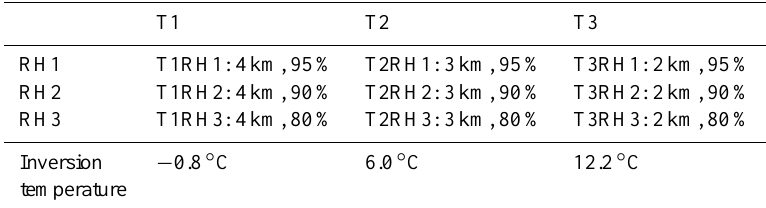
Table 1. A summary of the notations, inversion base height and RH levels in the cloudy layer for the nine different initial atmospheric profiles. The temperature at the inversion is presented in the bottom row. For each profile 10 simulations were run with aerosol concentrations of 5, 25, 125, 250, 500, 1000, 2000, 3000, 4000 and 10000cm − 3